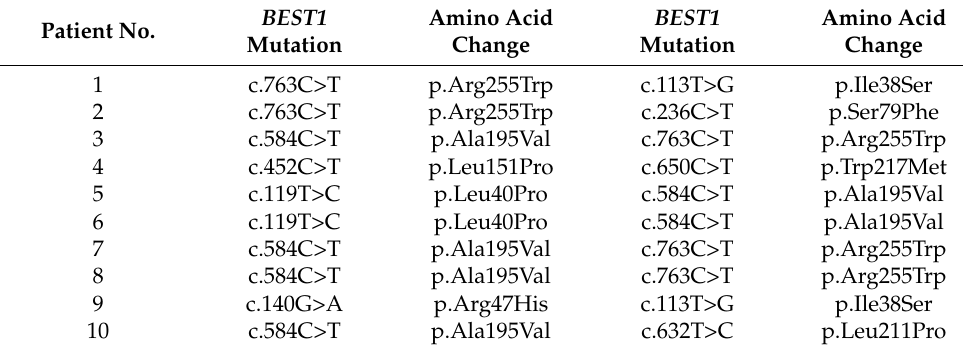
Table 3. List of BEST1 mutation variants and predicted effects.